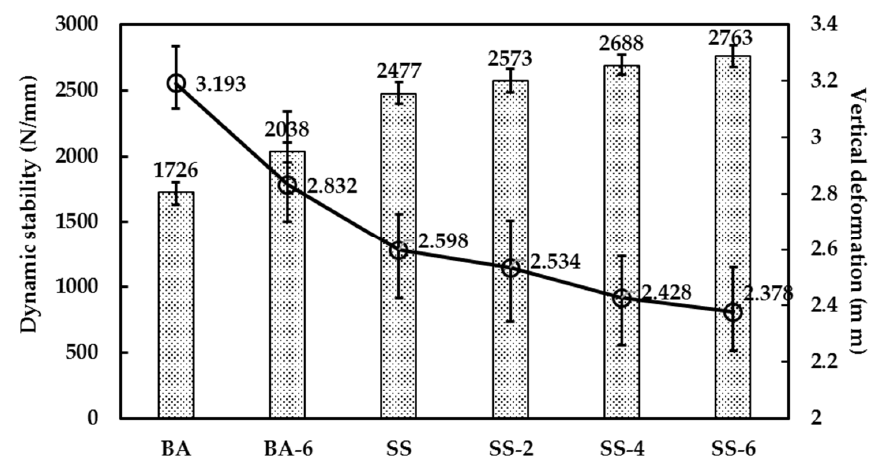
Figure 9. Dynamic stability and vertical deformation of di ff erent asphalt Figure 9 Dynamic stability and vertical deformation of different asphalt concrete.